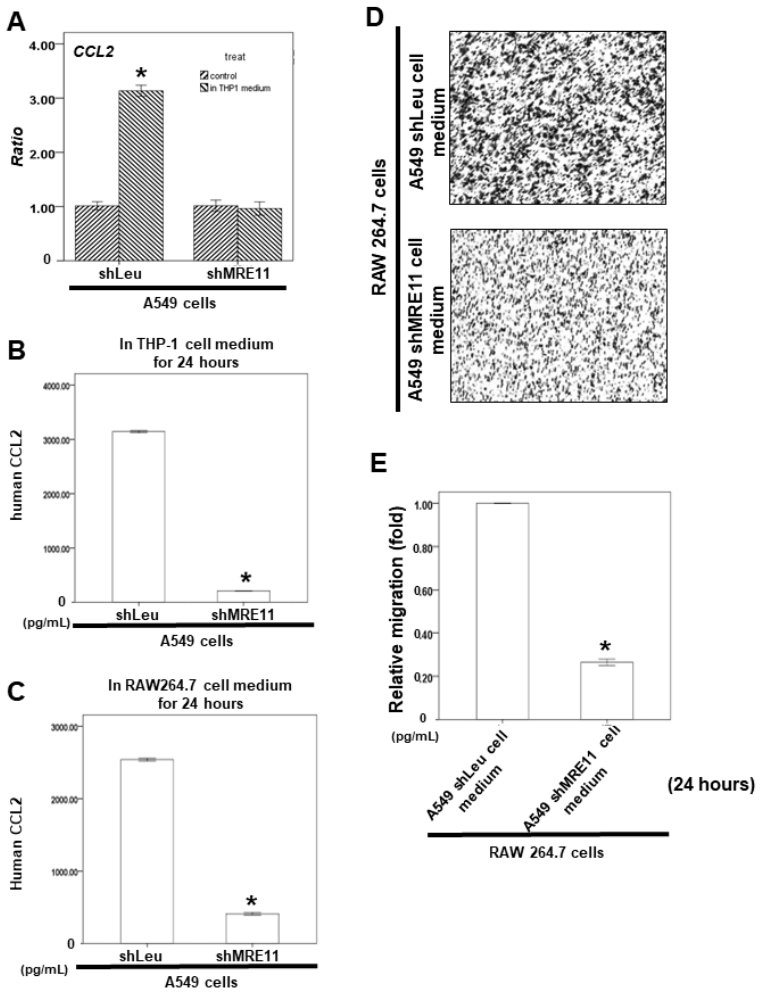
Figure 5. The effect of MRE11 on RAW 264.7 cell recruitment in an in vitro model. ( A ) Total mRNA was extracted from A549 shLeu and A549 shMRE11 cells after treatment with or without the conditional medium of THP-1 for 24 h. The coding regions of human CCL2 were used as probes for real-time polymerase chain reaction analysis. ( B , C ) For ELISA, the medium was collected from A549 shLeu and A549 shMRE11 cells after treatment with or without the conditional medium of THP-1 or RAW264.7 cells for 24 h. The secretion of human CCL2 was measured by ELISA kits. ( D , E ) For the macrophages’ recruitment ability of human lung cancer cells, the conditioned medium from A549 shLeu or A549 shMRE11 cells was collected and placed in the lower chamber. Then, RAW 264.7 cells were then placed in the upper chamber for the migration assay. ( D ) After incubation for 24 h, the photographs ( × 100) were taken, and the migratory cells were measured using AlphaEase ® FC StandAlone Software. ( E ) The quantification of the migratory RAW 264.7 cell numbers in each group was normalized to the control. The results were from three independent experiments. (Error bar = mean ± S.E.M. Asterisks (*) mark samples significantly different from the blank group with p <